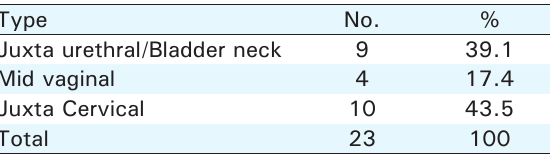
Table 1. Anatomical types of the fistulas